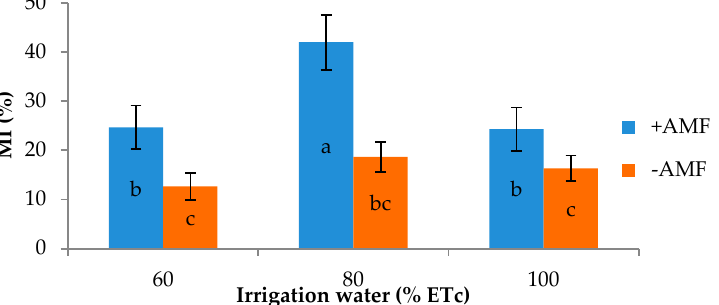
Figure 4. Effect of irrigation treatments and plant inoculation with arbuscular mycorrhizal fungi (AMF) on the mycorrhizal index (MI) of melon plants during two years of experiments (bars with different letters are significantly different at p < 0.05 according to the LSD test).